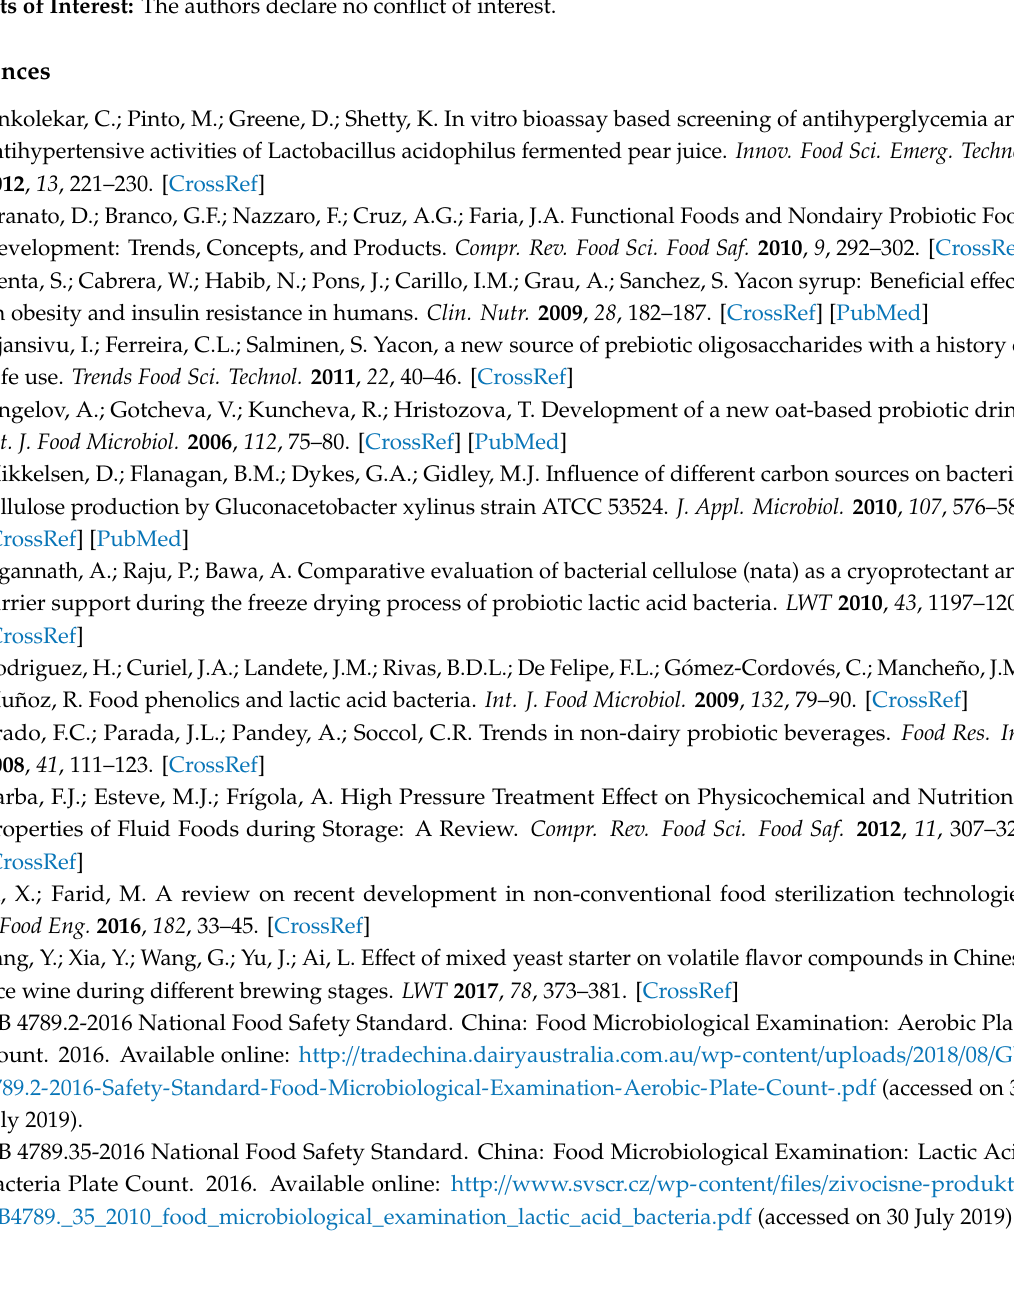
Figure S1: Growth changes of LAB in the fermentation of TP and HHP-treated YLL juice, Table S1: Individual FAA content in di ff erent treated YLL juice, Table S2: Volatile compounds identified by GC-MS analysis in the fresh, TP-treated, fermented TP-treated, HHP-treated and fermented HHP-treated YLL juice, Table S3: Cumulative contribution and predication performance (PCA, PLS-DA) of di ff erent treated YLL juice, Table S4: Potential markers of volatile components of di ff erent treatment of YLL